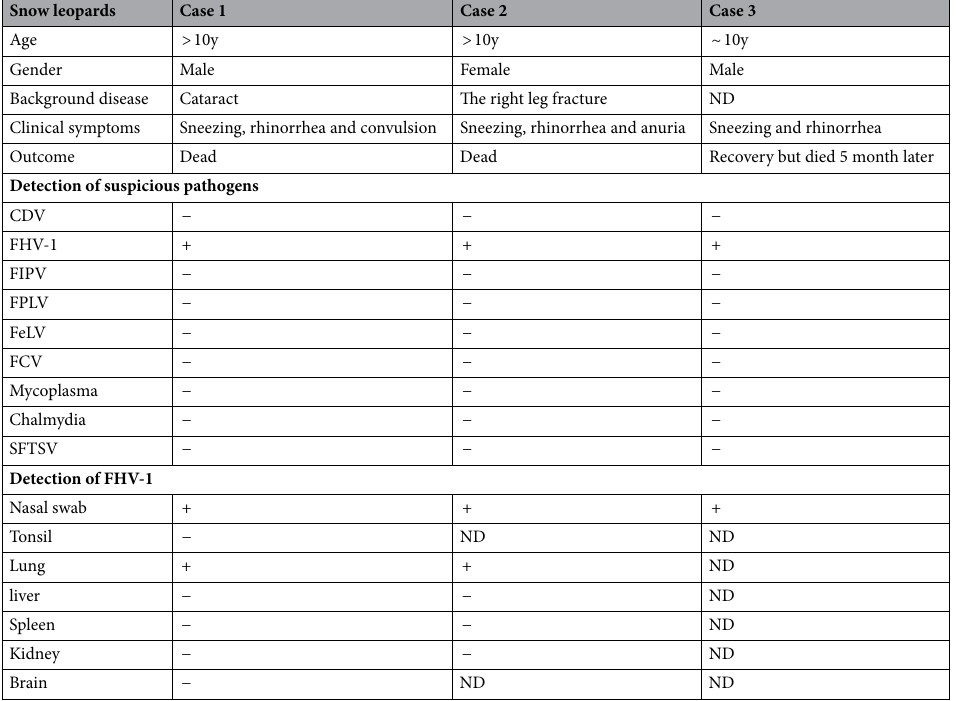
Table 1. The clinical information and pathogen examination results of three snow leopards. +, positive; −, negative; ND, No data. The method of detection of suspicious pathogens is real-time qPCR. The method of detection of FHV-1 in tissues is